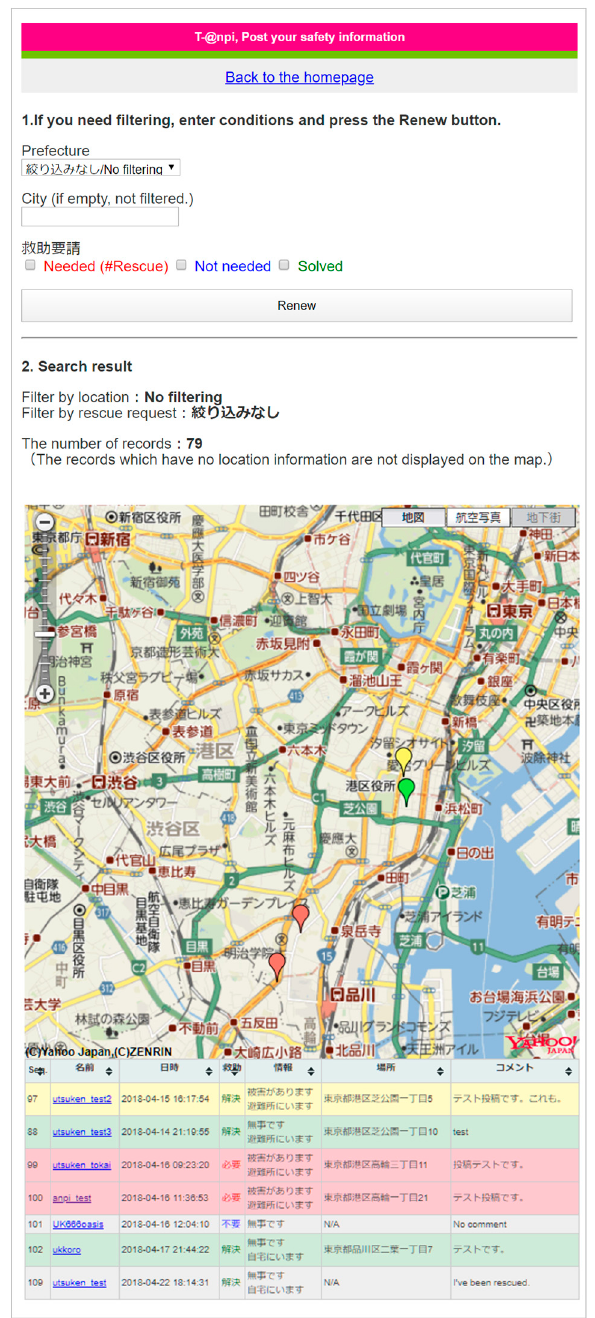
Figure 11. List and map view page for the supporting users.